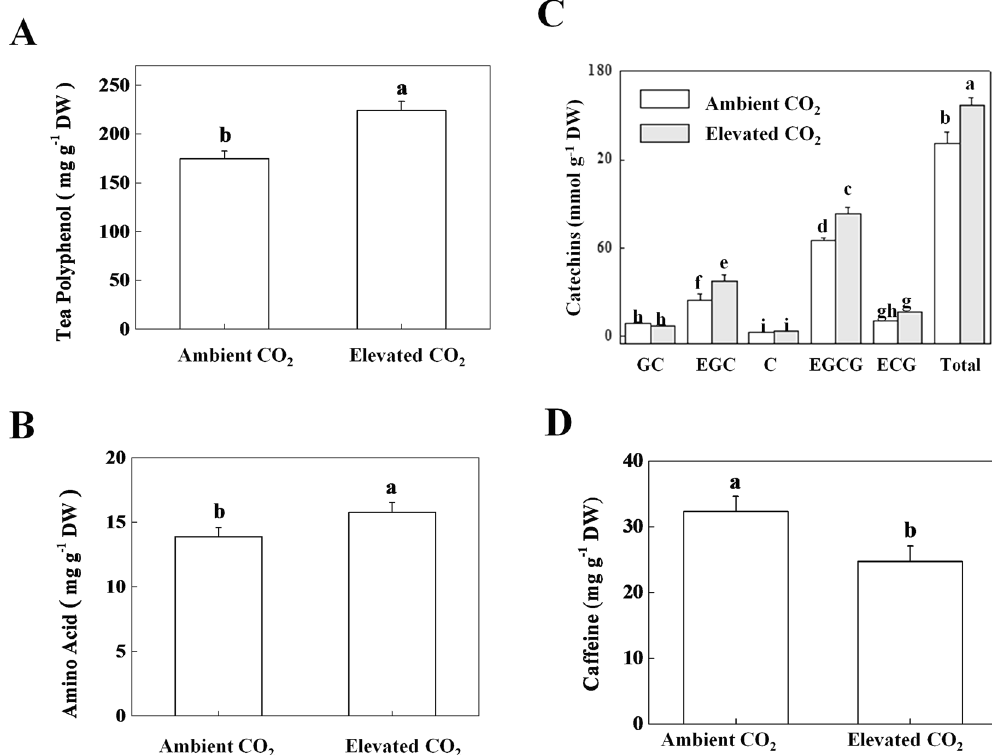
Figure 4. Changes in polyphenol, amino acid, and caffeine concentration in leaves of tea seedlings grown at ambient (380 µ mol mol − 1 ) or elevated CO 2 concentration (800 µ mol mol − 1 ). ( A ) Total tea polyphenol, ( B ) total amino acids, ( C ) Individual catechins, and ( D ) Caffeine concentrations. Leaf samples were harvested after exposure of tea plants to different concentrations of atmospheric CO 2 for 24 days. Data are the means of four replicates ( ± SD). Mean denoted by different letters indicate significant differences between the treatments ( P < 0 . 05 ).